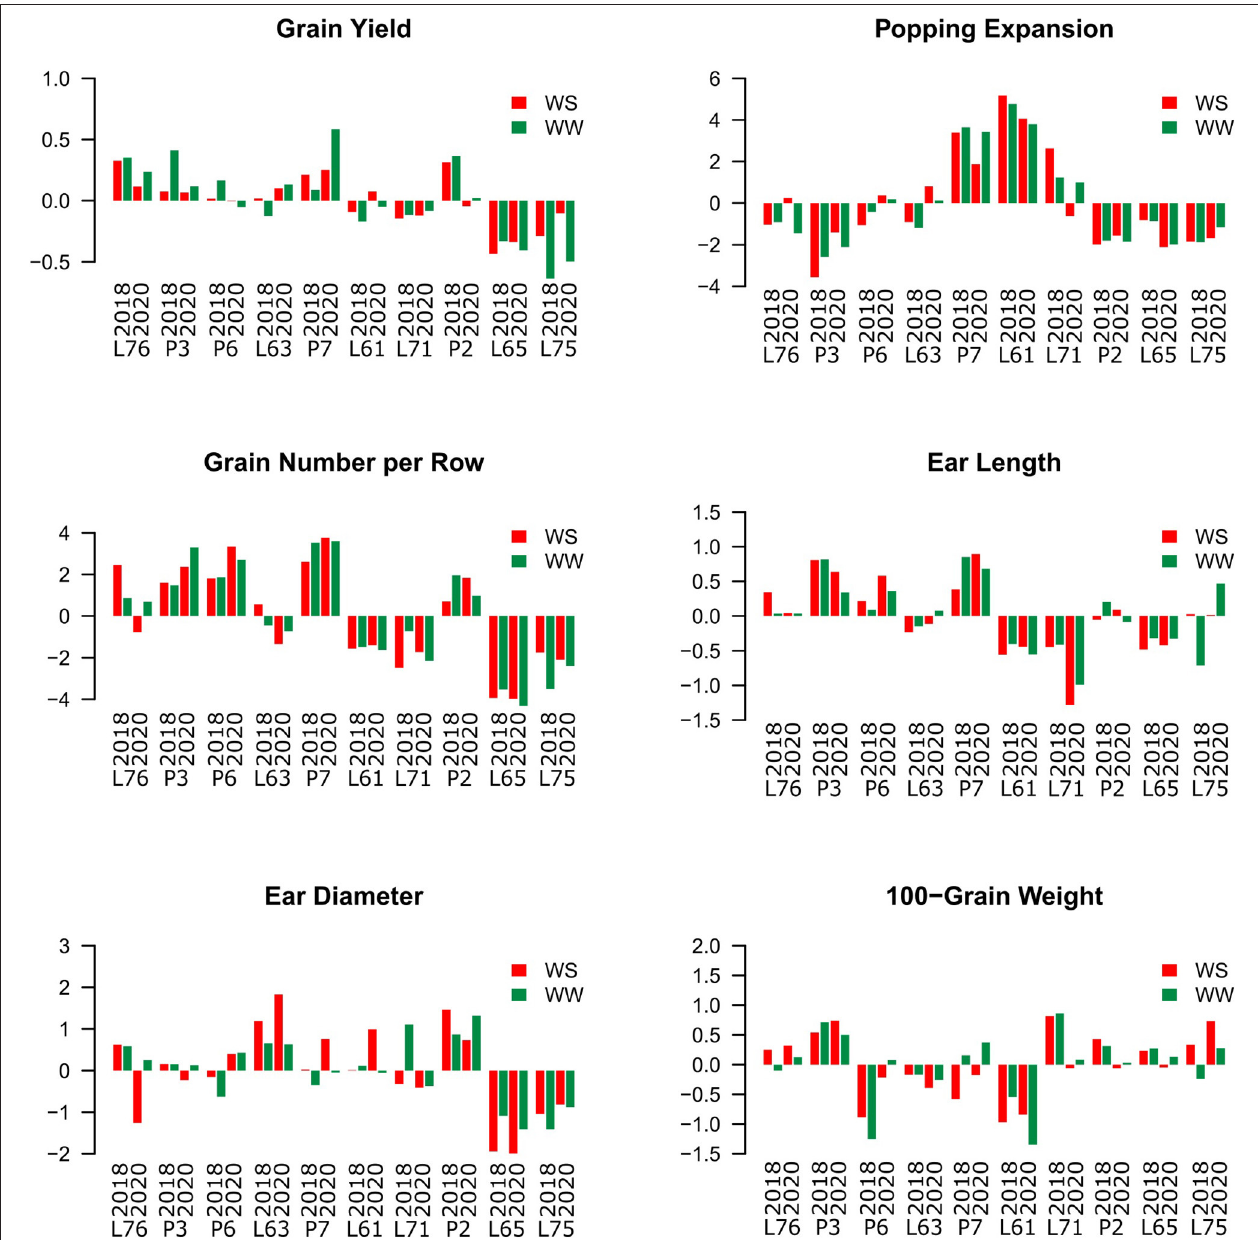
FIGURE 2 | Estimation of the general combining ability (GCA) effects of popcorn inbred lines for the agronomic-assessed traits under two water conditions (WCs) and crop seasons in 2018 and 2020. Water stress (WS) is represented by red bars and the WW condition is represented by dark-green